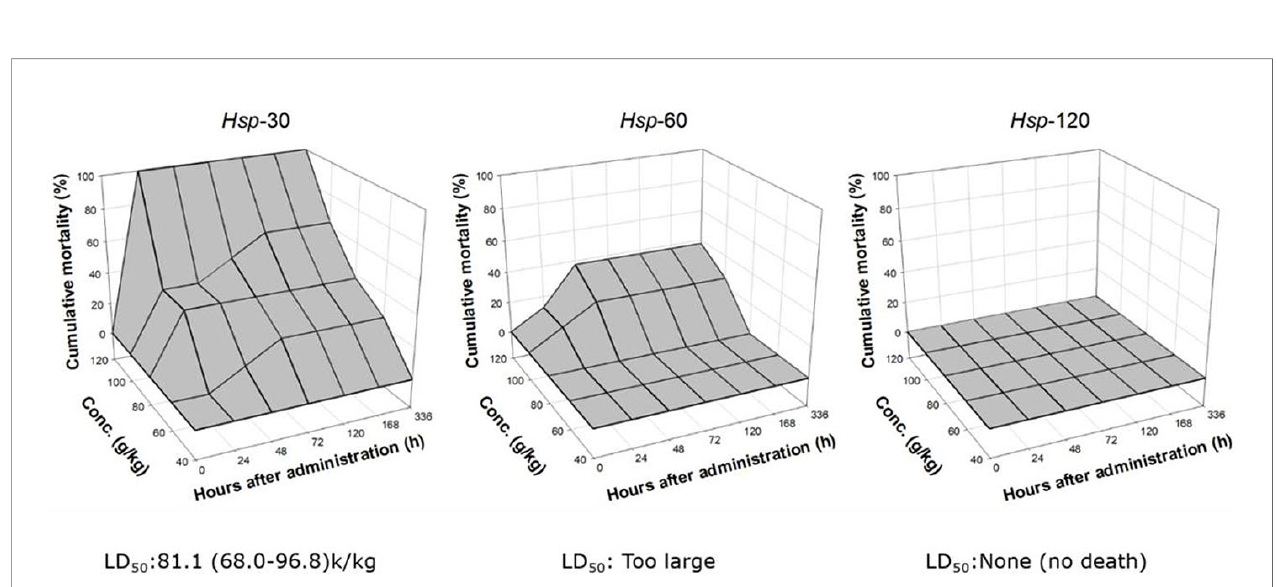
FIGURE 3 | Cumulative mortalities of mice after oral administration of Hsp -30, Hsp -60, and Hsp -120 (g/kg) with LD 50 value and associated 95% con fi dence